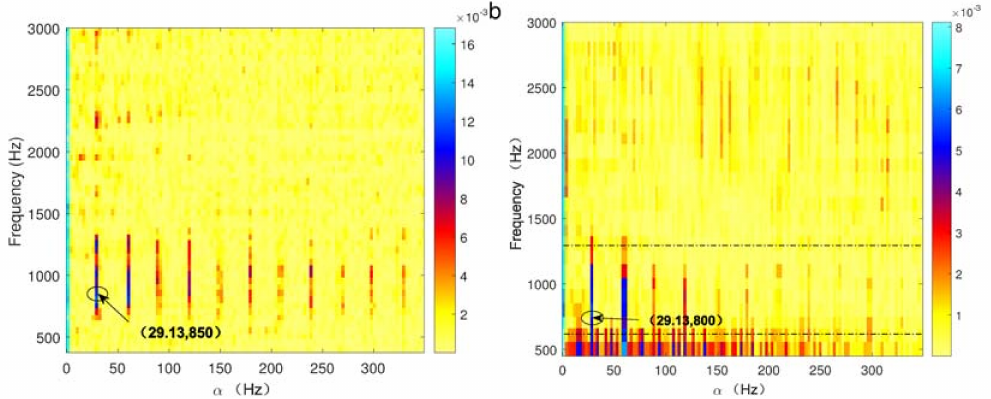
Figure 18. The MID SCoh ∆